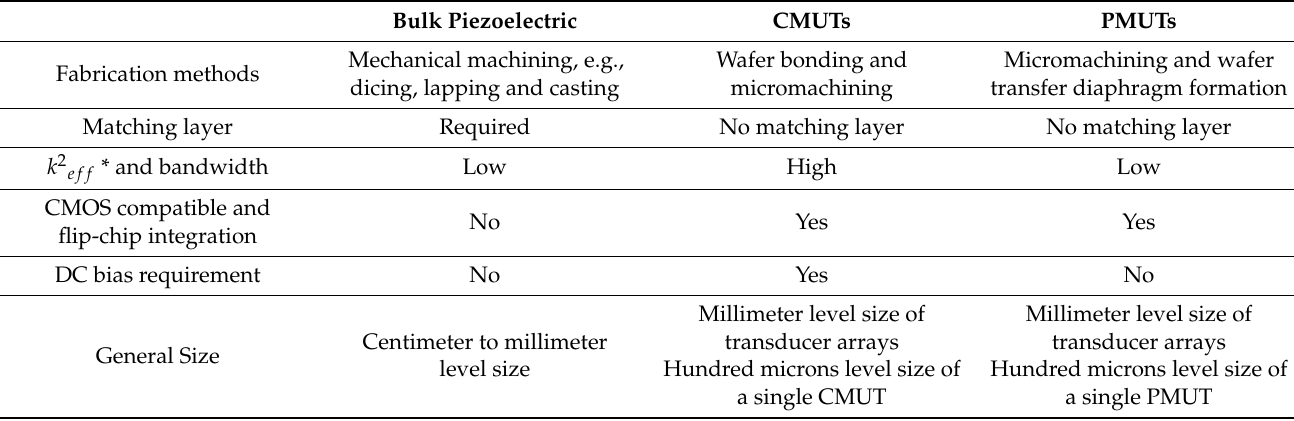
Table 1. The characteristics of bulk piezoelectric transducers, CMUTs and PMUTs [45,51–54,56–59].